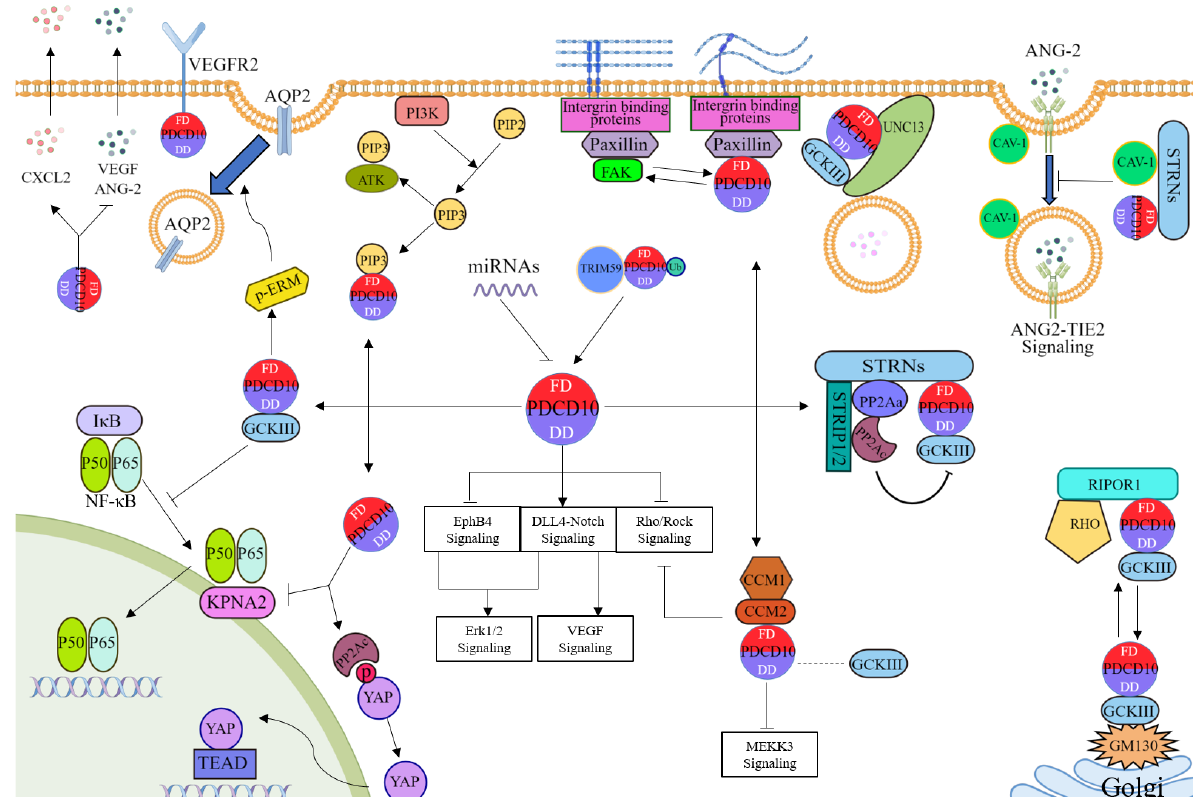
Figure 2 summarizes the cellular interactors, regulators, and signaling of PDCD10.